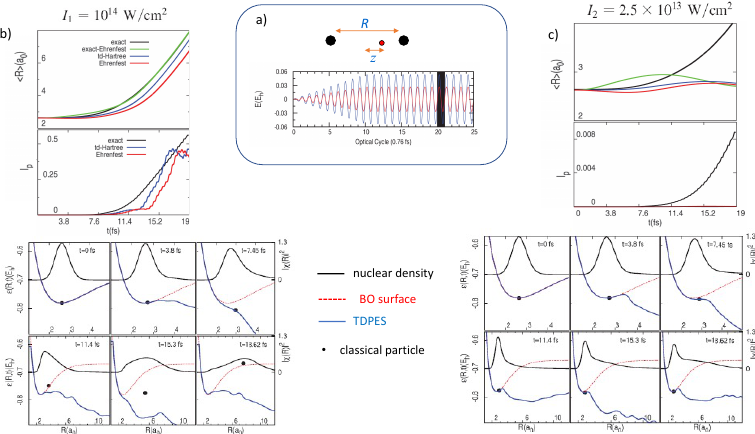
Figure 1. 1D model of laser-driven H + dissociation: ( a ) Shows a sketch of the model molecule, 2 and the electric field of the λ = 228 nm laser applied to the system, with the shaded part indicating the optical cycle for which snapshots for two different intensities are shown in the other panels. ( b ) The top panel shows (cid:104) R (cid:105) ( t ) as a measure of dissociation, for the stronger field intensity of I 1 , (cid:82) (cid:82) dz dR | Ψ ( z , R , t ) | 2 which measures ionization through and the lower panel shows I p = 1 − box e the number of electrons outside a box chosen of size | z | ≤ 10 a.u; the exact is shown in black, while predictions of the traditional classical Ehrenfest method is in red, the quantum time-dependent Hartree in blue, and a classical evolution on the exact TDPES (labelled as exact-Ehrenfest) as green. The lowest panel shows time-snapshots of the nuclear density and the TDPES, and the black dot shows the position and energy of a classical particle evolving under the TDPES. ( c ) This shows the same quantities as in ( b ) but for the weaker field intensity I 2 . Reproduced from ref. [17] with the permission of AIP